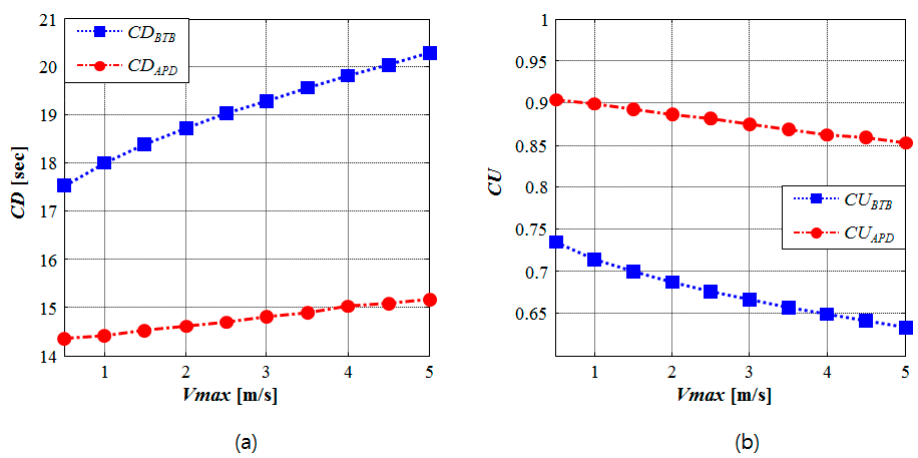
Figure 10. ( a ) The CD and ( b ) the CU of the APD-TDMA and the BTB-TDMA versus the maximum speed of nodes when the number of nodes is 25 and the network range is 1500 m.